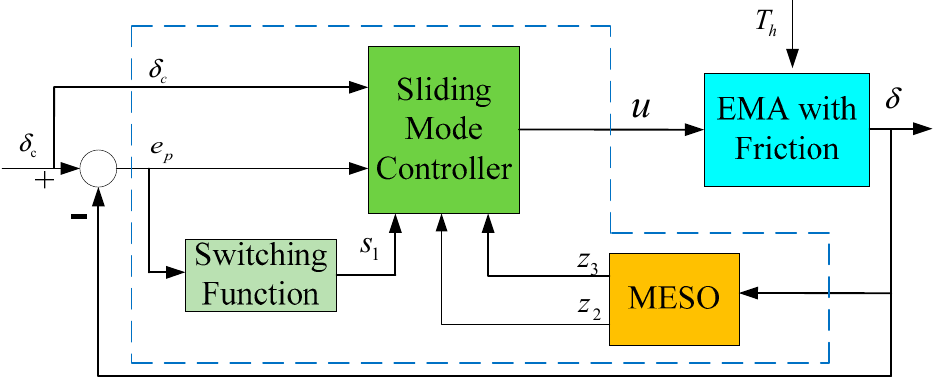
Figure 8. Composite SMC control diagram of EMA.